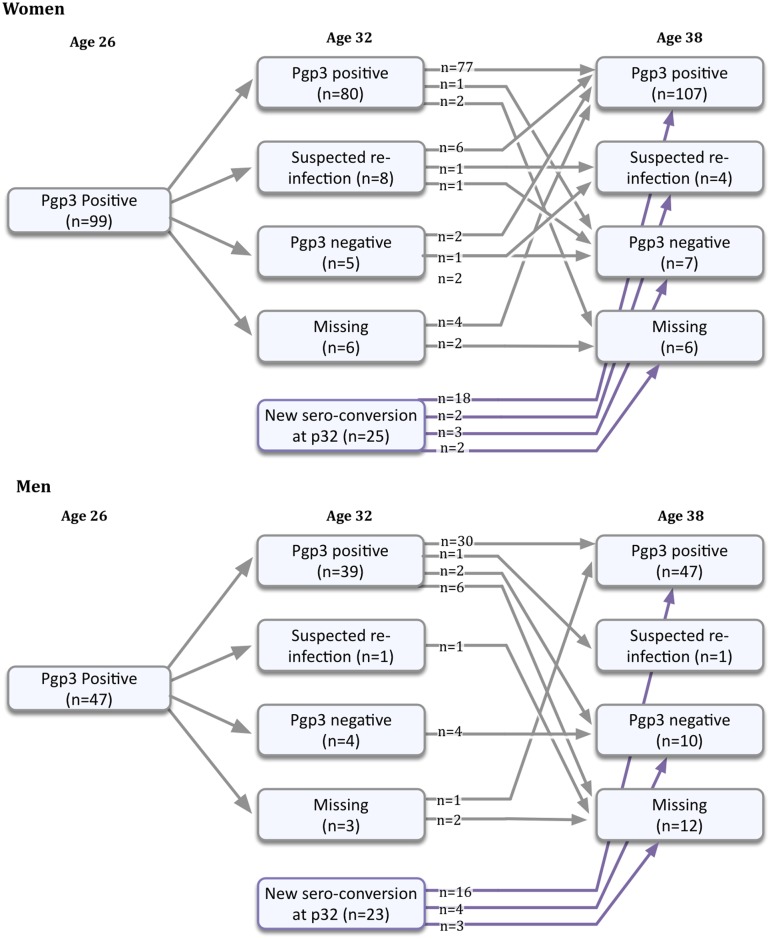
Flowchart showing the history of detectable Pgp3 antibody in women and men at age 26, 32 and 38 years.The number of women and men testing Pgp3 antibody positive at age 26 is given. Shown at age 32 and 38 are the numbers of these positive individuals who: i) maintained Pgp3 seropositivity with no self-report of re-exposure to Ct, ii) remained Pgp3 positive, but also reported a re-infection with Ct, iii) had become seronegative, and iv) were missing at that time point. Finally, the numbers of women and men who became Pgp3 seropositive between age 26 and 32 together with their subsequent antibody status and infection history by age 38 are shown.